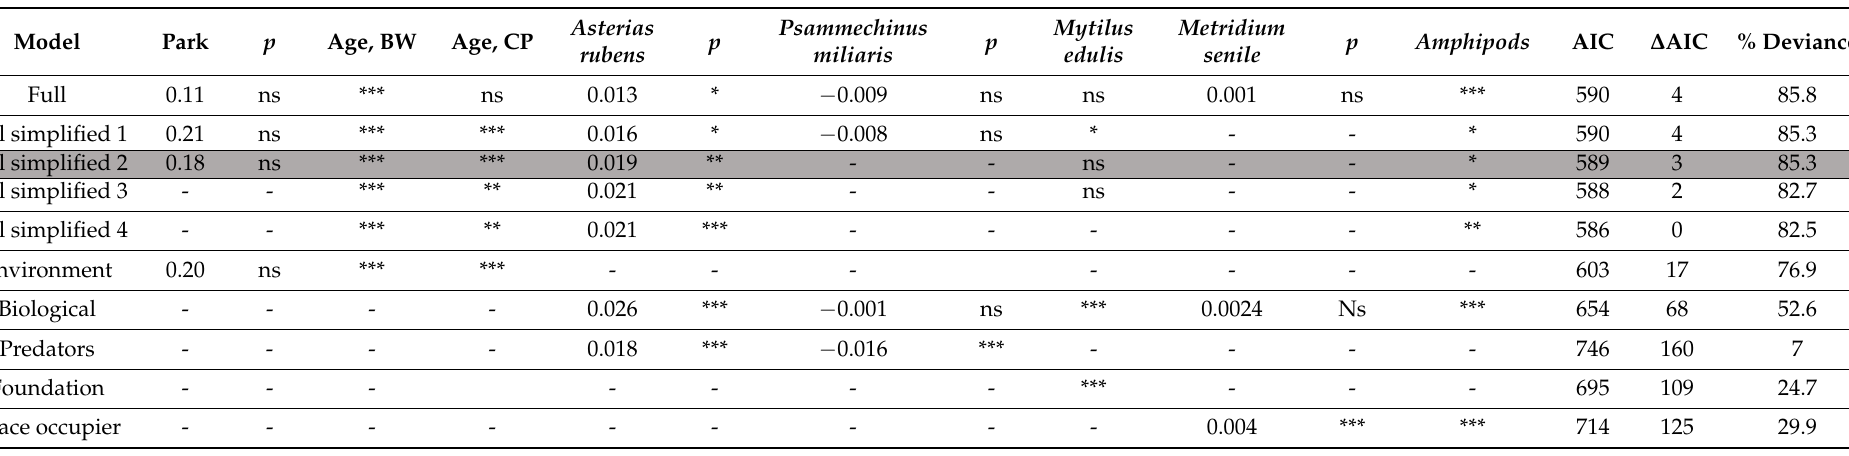
Table 3. Overview of the full model and alternative models considered (excluded variables indicated with -) for richness. The model with the best fit is highlighted. For richness, there were three models with the ∆ AIC value <3, thus we choose the best-fitting model as the one with the highest percentage of deviance explained (i.e., 85.3%). p -value for all of the variables ( p < 0.001: ***, p < 0.01: **, p < 0.05: *, p > 0.1: ns) and estimate for linear variables.